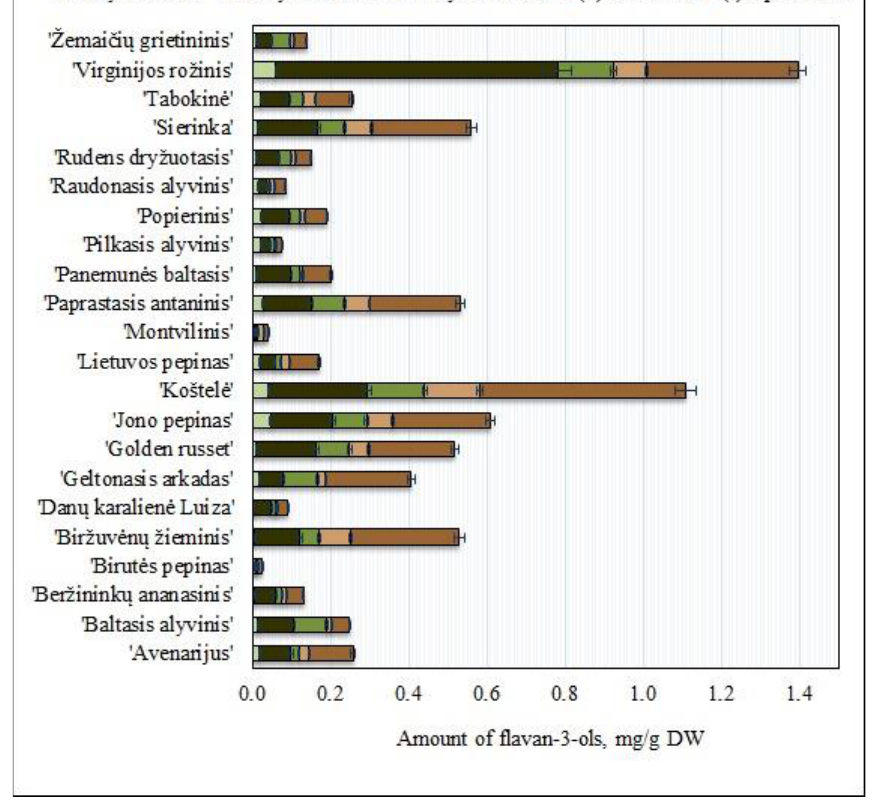
Figure 2 Figure 2. Variability of the amount of flavan-3-ols in fruit samples of heirloom apple